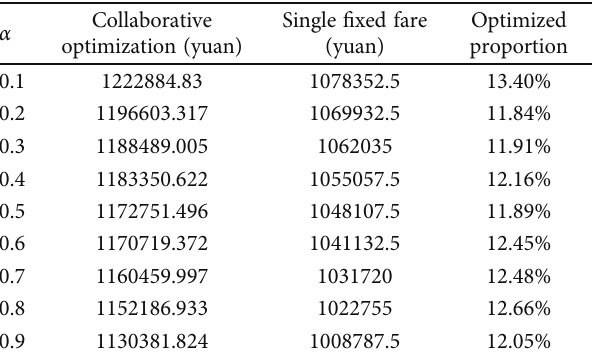
Table 5: Total revenue at di ff erent con fi dence